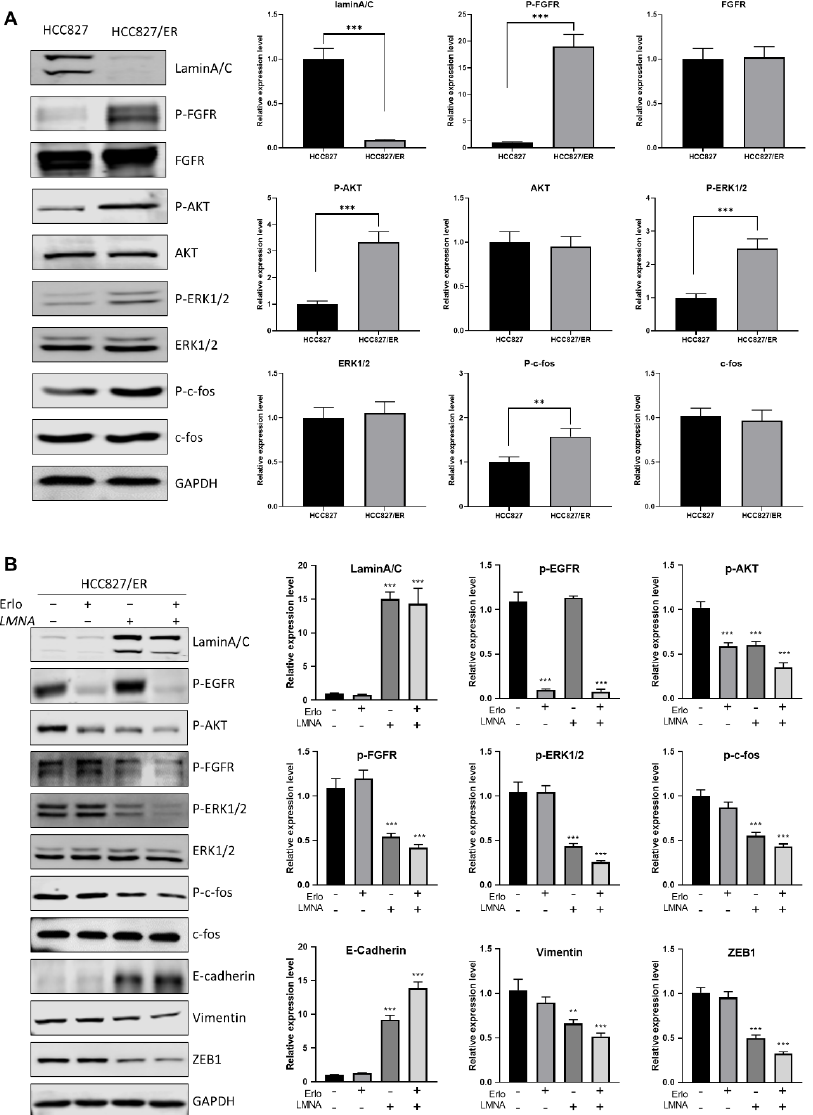
Figure 7. LMNA reversal of EMT by regulation of the FGFR/MAPK/c-fos signaling pathway. ( A ) Western blot analysis was performed to detect the expression of laminA/C, P-FGFR, P-AKT, P-ERK1/2, and P-c-fos in HCC827 and HCC827/ER cells. ( B ) HCC827/ER cells were transfected with LMNA expression vectors and treated with or without 2.5 μ M erlotinib for 24 h, then subjected to Western blot analysis using the indicated primary antibody. Data are presented mean ± SD from three independent experiments. Significant differences are indicated as follows: Student’s t -test, ** p < 0.01, *** p < 0.001.